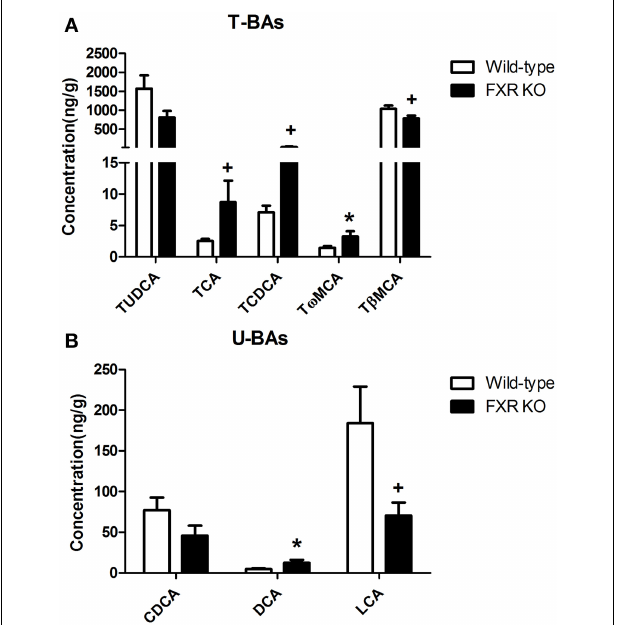
FIGURE 9 | FXR KO on BAs in brain. In comparison with wild-type controls, FXR KO mice displayed higher concentrations of TCA, TCDCA, T ω MCA, and DCA (A) but lower concentrations of T β MCA and LCA in brain (B) . N = 7 –10/group; * p < 0 . 05 ; + p < 0 . 1